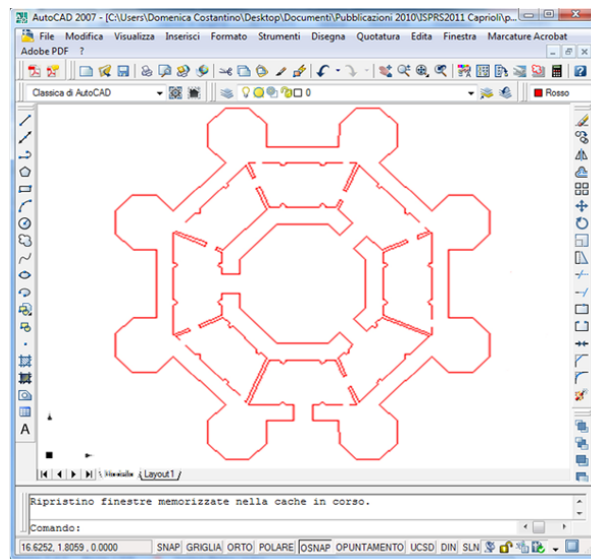
Figure 26. Sample section in CAD